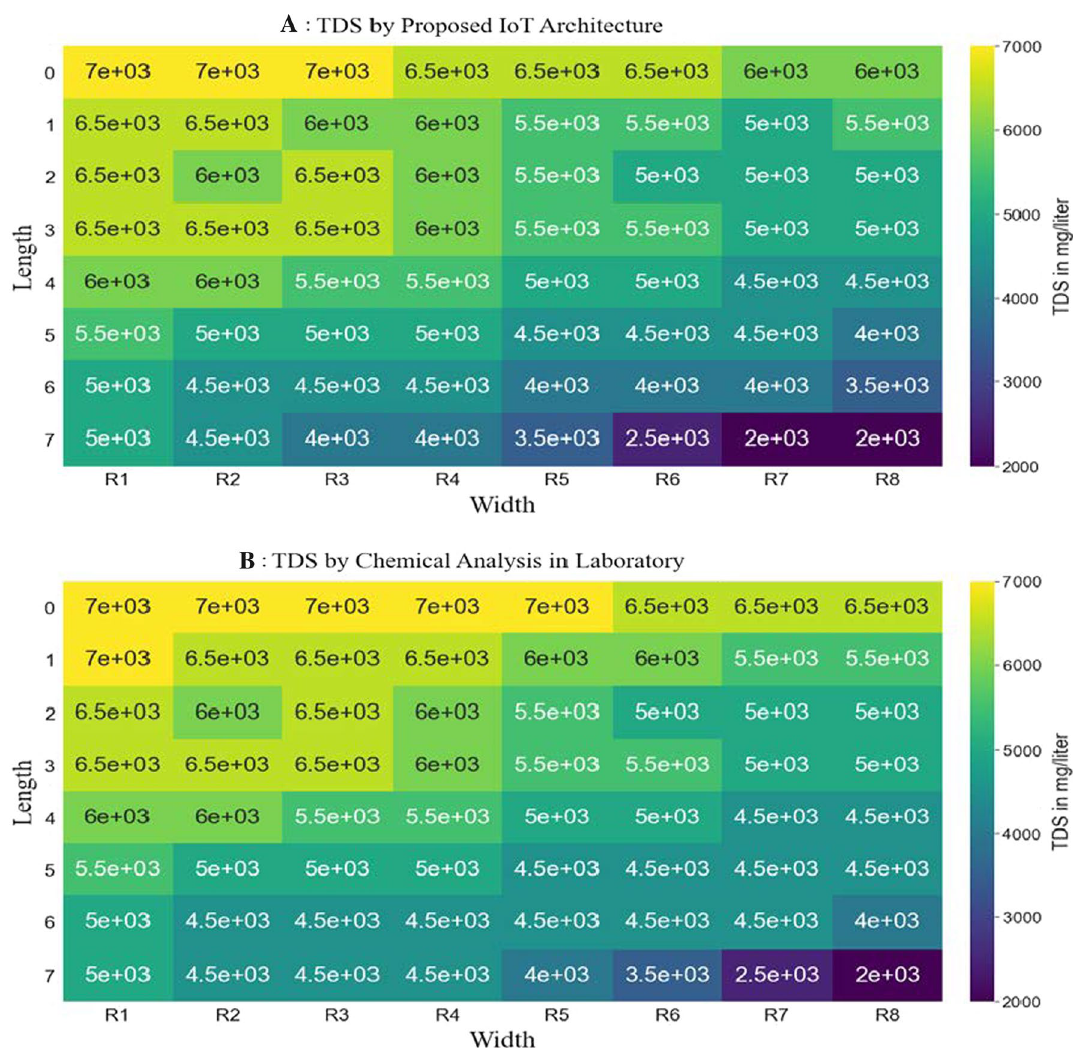
Fig. 15 TDS values by two